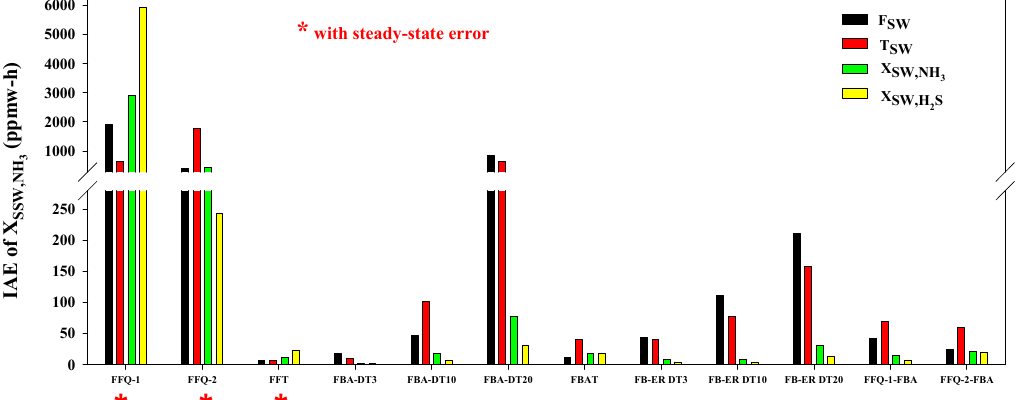
Figure 11. Integrated absolute error (IAE) of NH 3 concentration results of all control schemes for the sour water feed stream disturbances, including flowrate, temperature, NH 3 concentration, and H 2 S concentration. (* with steady state offset).